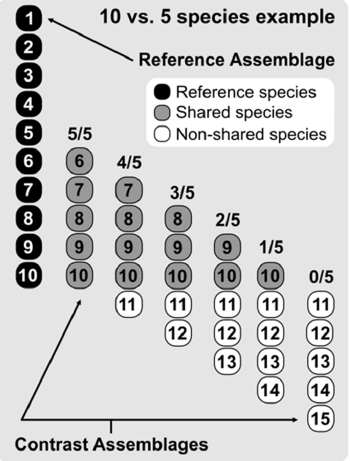
Figure 2. Example of a gradual species composition overlap between two paired assemblages considering progressive differences in species richness. The hypothetical reference assemblage has 10 species and the contrast assemblage has five species. To evaluate differences in gradual species composition overlap, we performed pairwise calculations between the reference assemblage and those sharing 5–0 species with it.